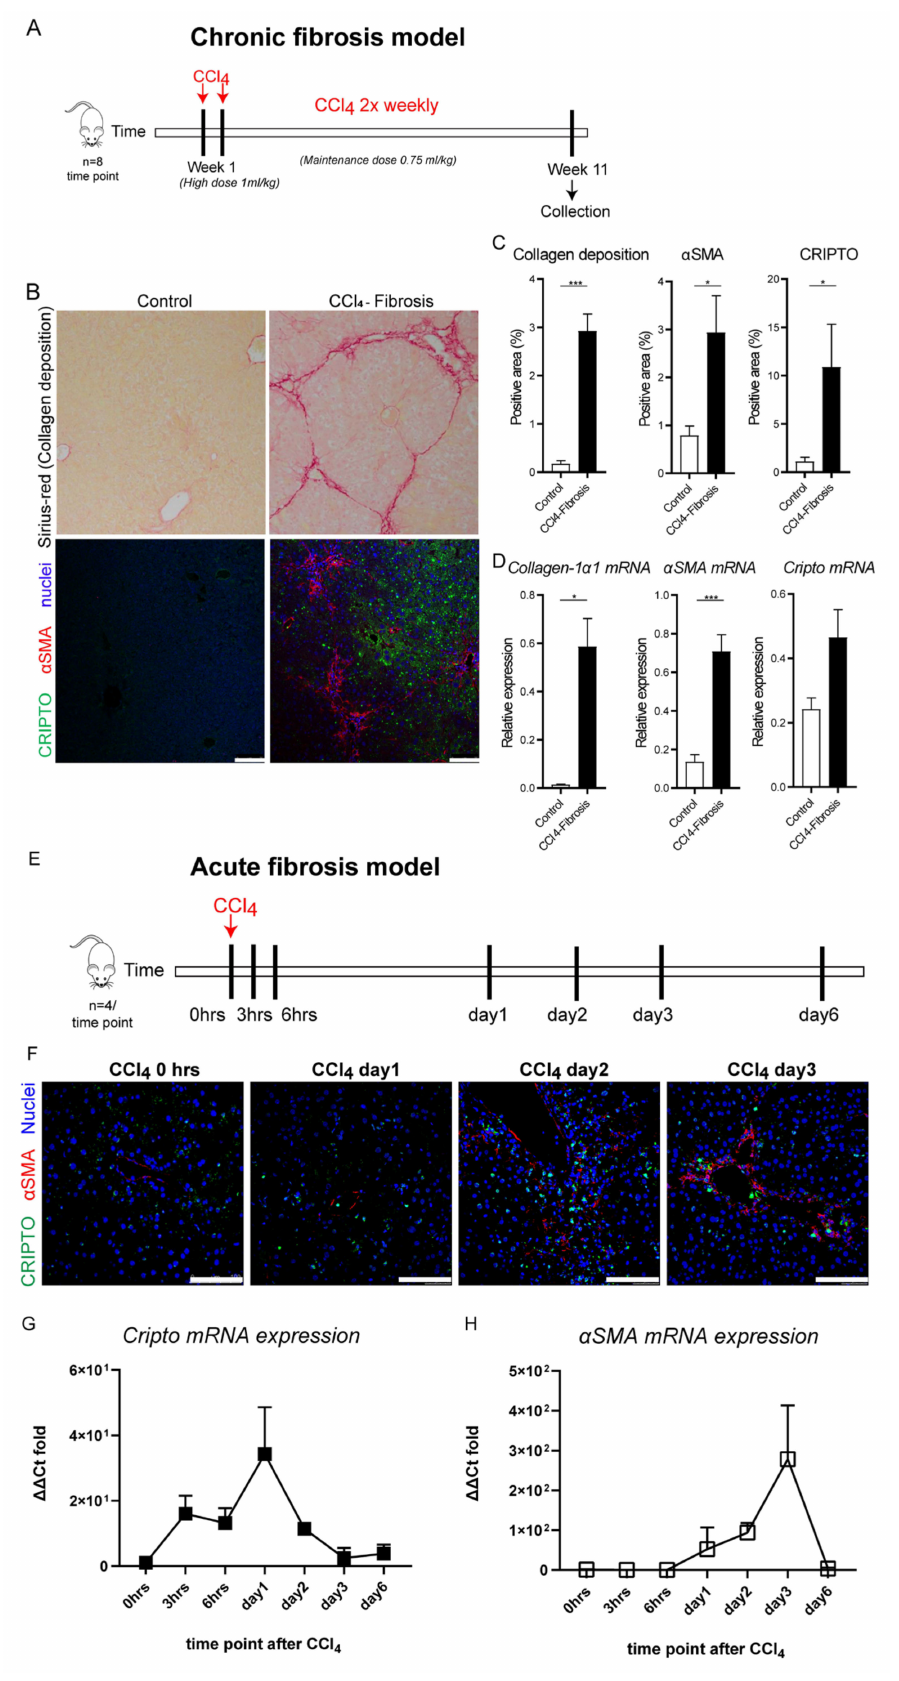
Figure 2. CRIPTO is upregulated in a CCl 4 mouse model for chronic liver fibrosis and is